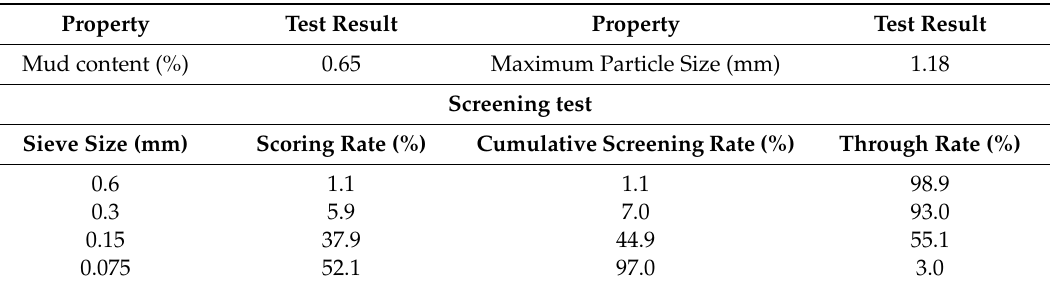
Table 3. Basic performance of fine sand.